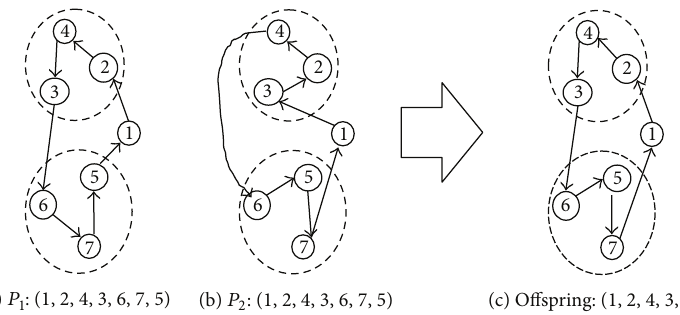
Figure 2: Example of sequential constructive crossover